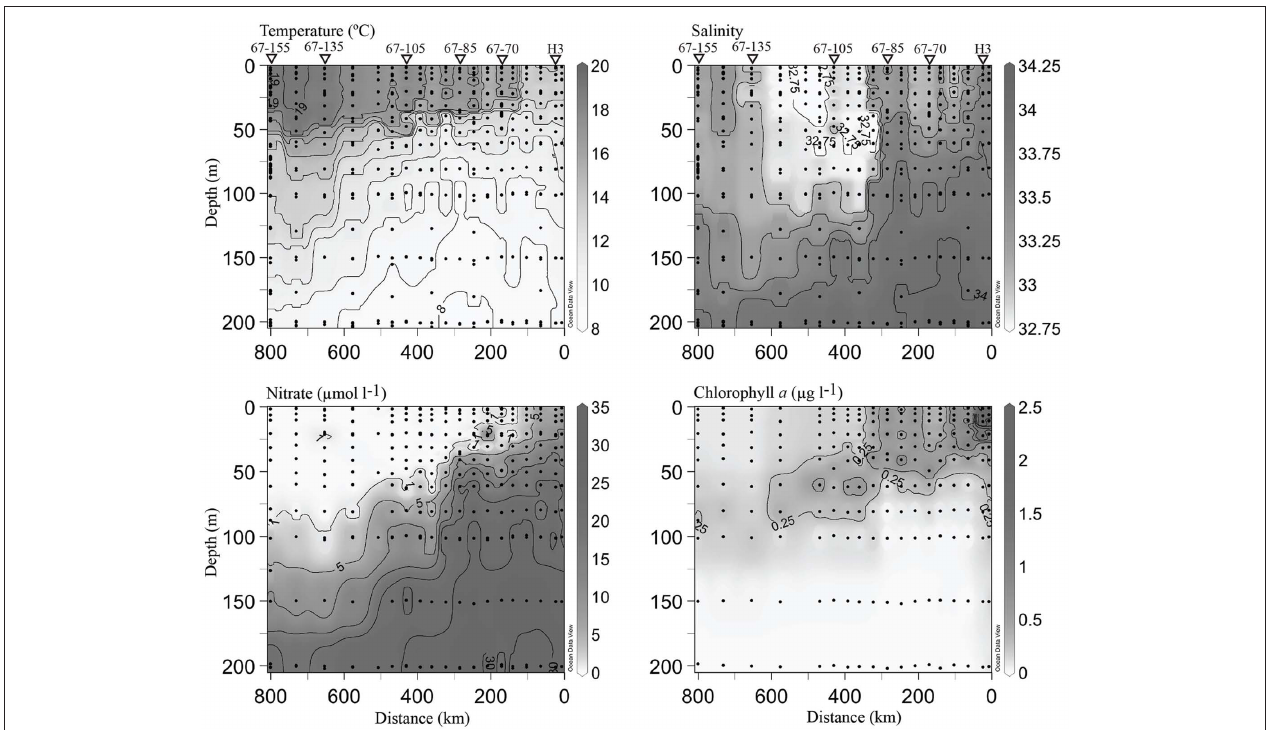
FiguRe 4 | Hydrographic conditions along the line 67 transect from Moss Landing, CA (0 km) to station 67–155 ( ∼ 800 km from shore). Black circles indicate locations of discrete measurements collected via the CTD rosette. Contour lines are drawn on intervals of 1, 0.25, 5, and 0.25 for individual temperature, salinity, nitrate